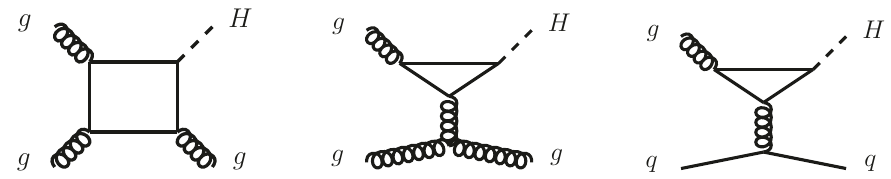
Figure 1 . The one-loop Feynman diagrams that contribute to the quark-loop induced processes gg ! Hg and qg ! Hq